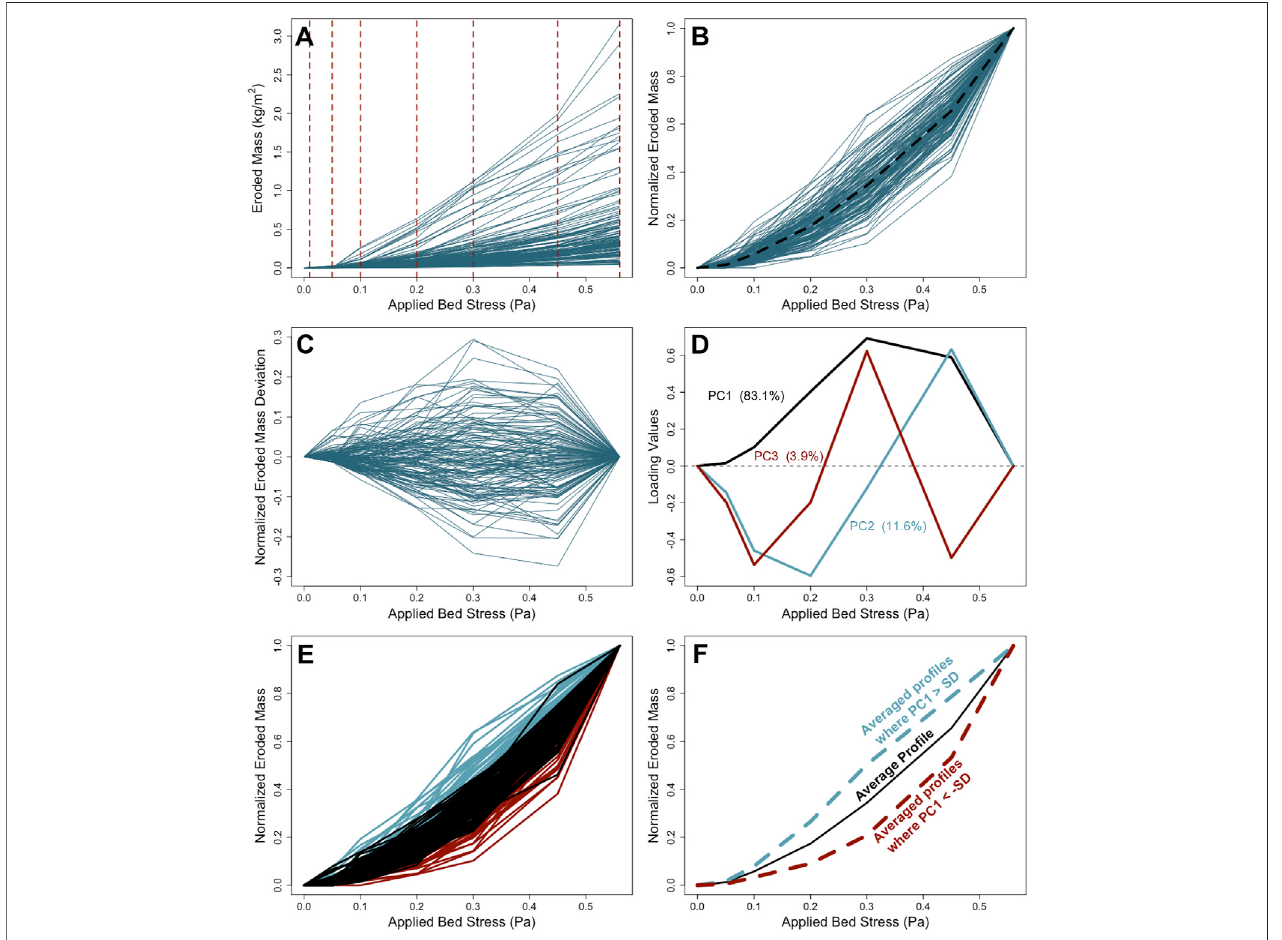
FIGURE5 | Erosionpro fi le shape normalization process. (A) Interpolated Gust outputdata with interpolation points highlighted by dashed red lines. Each pro fi le in (A) was divided by its eroded mass value at 0.56 Pa, resulting in normalized erosion shapes bounded between 0 and 1 in panel (B) . The average pro fi le in (B) (dashed black line) was subtracted from all normalized pro fi les to center the data around zero in (C) . (D) Loading values for PC1, PC2, and PC3 determined from (C) for the All Sites data subset. (E) All Sites pro fi le shapes with PC1 scores within ± 1 standard deviation (SD) of zero (black), PC1 > 1 SD (blue), and PC1 < -1 SD (red). (F) Average pro fi le shapes for all normalized pro fi les in (E) , for those with PC1 > 1 SD, and for those with PC1 < -1 SD.